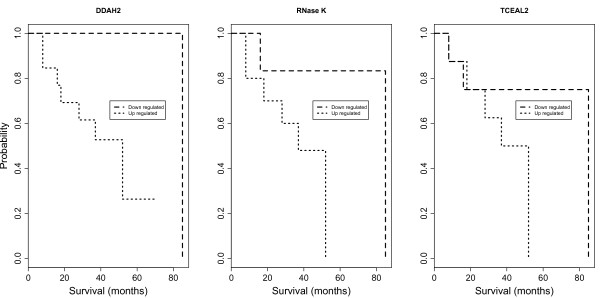
Kaplan-Meier estimates of overall survival stratified by up- and down-regulation for three genes including DDAH2, RNase K and TCEAL2.